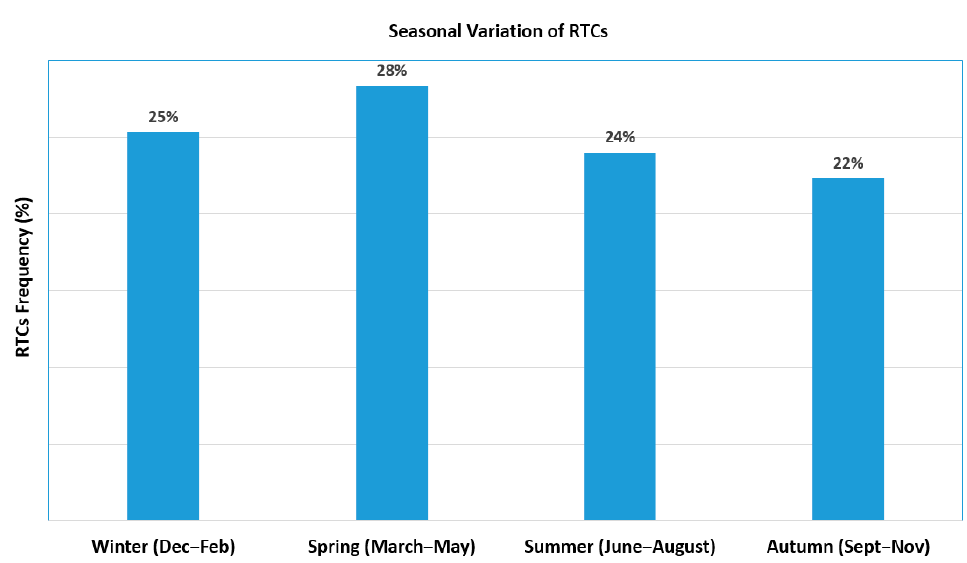
Figure 4. Seasonal variation of RTCs in the study area [51].